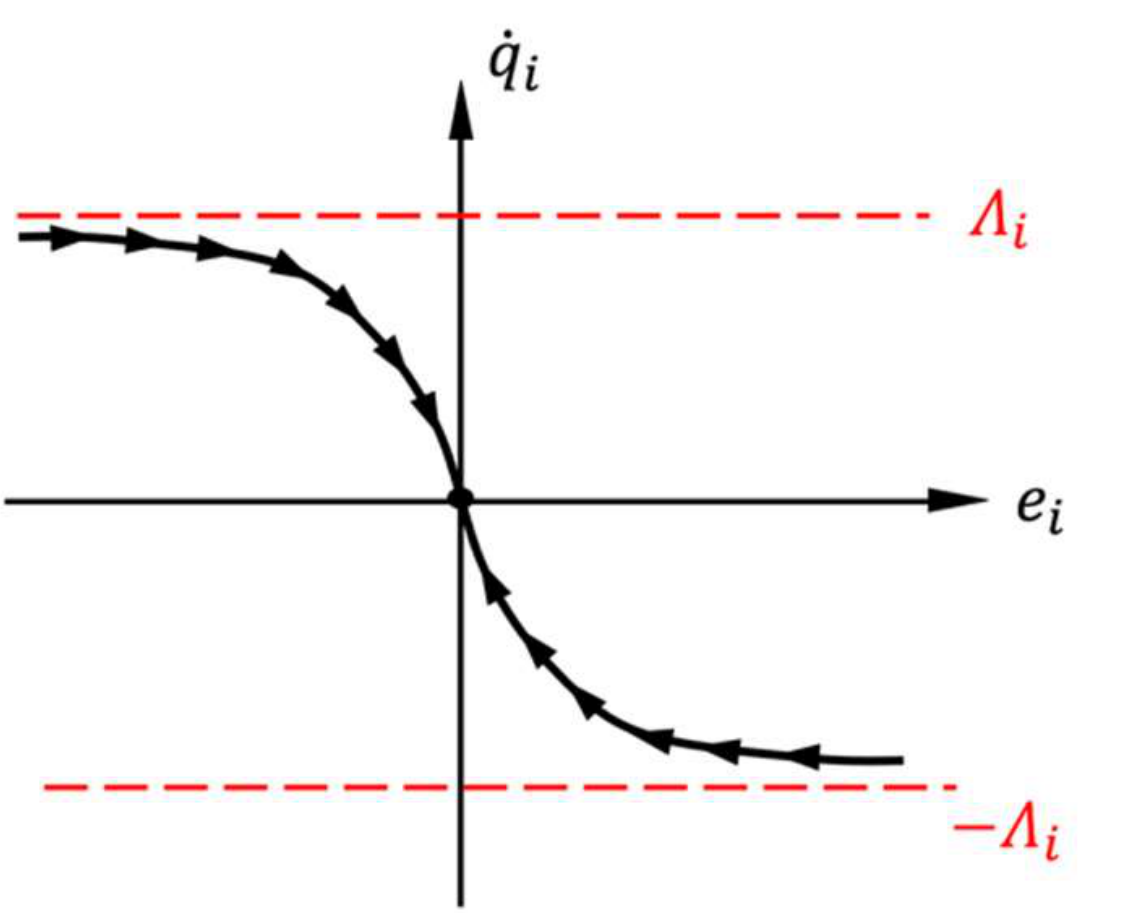
Figure 1. Converging behaviour of tracking error satisfying (24).The red line is the velocity constraint, and the black line with arrow is the converging trajectory.